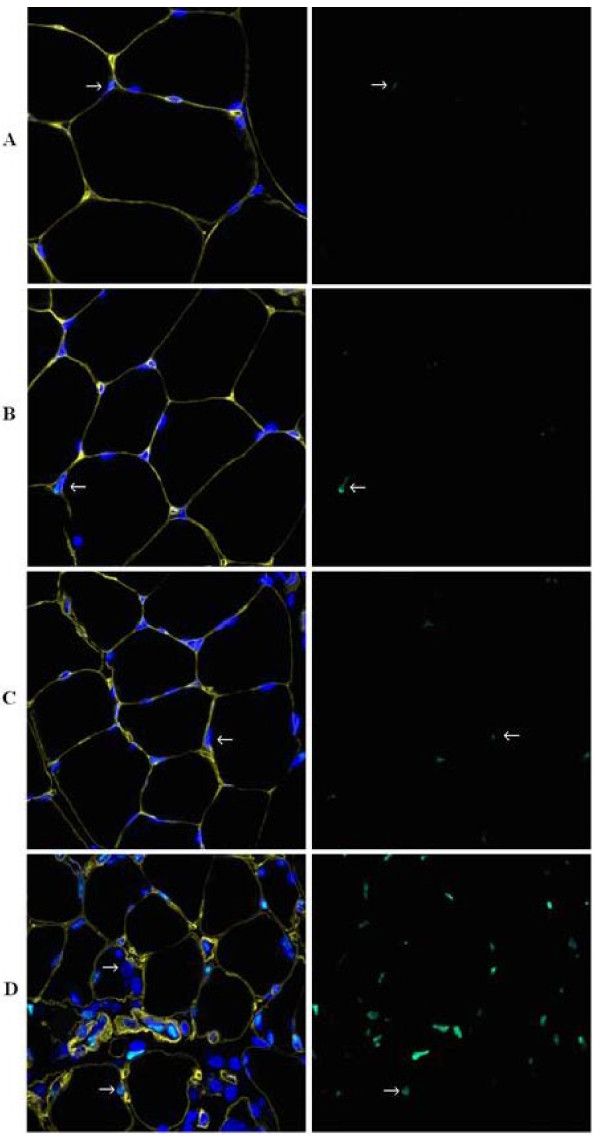
Immunofluorescence cytochemistry images. A: control rats, B: 0.25h-4d, C: 5-8d and D: 9-14d. Yellow shows laminin, blue is DAPI and green cleaved caspase-3. Arrows in A and C show apoptotic myonucleus, arrow in B shows apoptotic nucleus outside laminin, arrow in D shows a centralized swelled nucleus that might be an activated satellite cell.